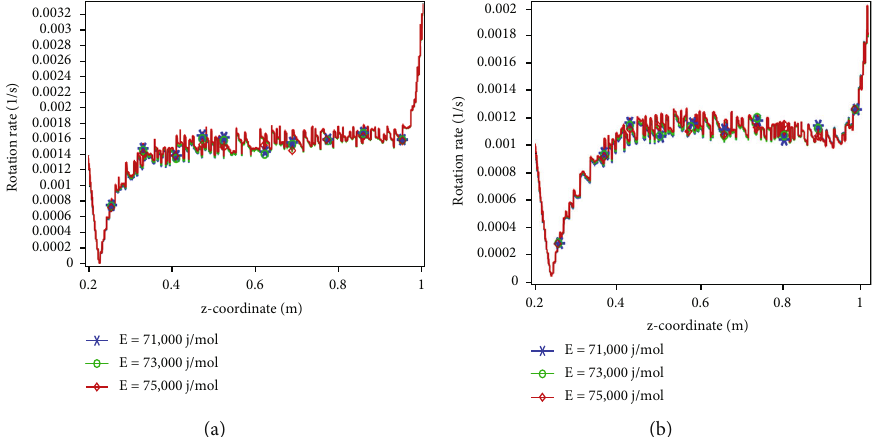
Figure 22: Measurement of rotation rate through the center middle of the downstream backward step channel with di ff erent activation energies and Re = 500 : (a) a = 0 : 5 and (b)